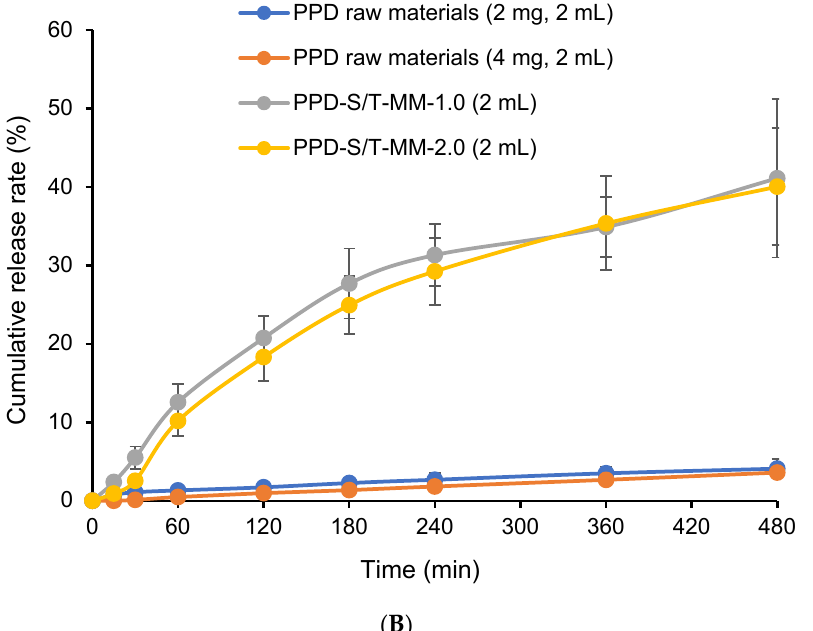
Figure 8. In vitro release of PPD (mean ± SD, n = 3). Release of PPD from PPD raw materials and PPD-S/T-MM in SGF ( A ); and release of PPD from PPD raw materials and PPD-S/T-MM in PBS containing 0.5% ( w / v ) Tween 80 ( B ).